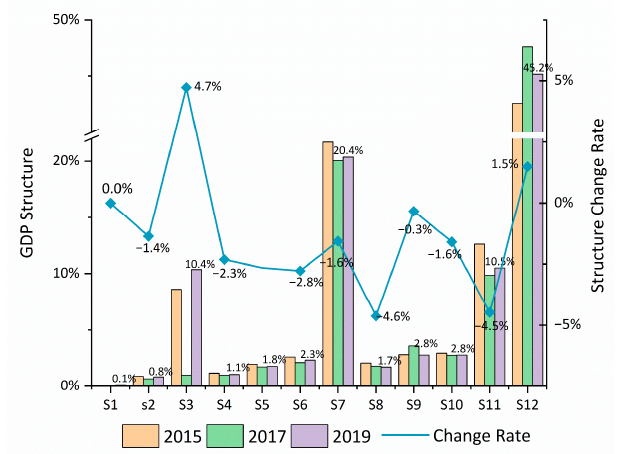
Figure A1. The proportion of industrial structure of 12 sectors in Shenzhen and their average change rate from 2015 to 2019; The line represents the average change rate of industrial structure from 2015 to 2019, the highest value is 4.7%, and the lowest is − 4.5%; The structure proportion of 12 industries in 2019 is marked.